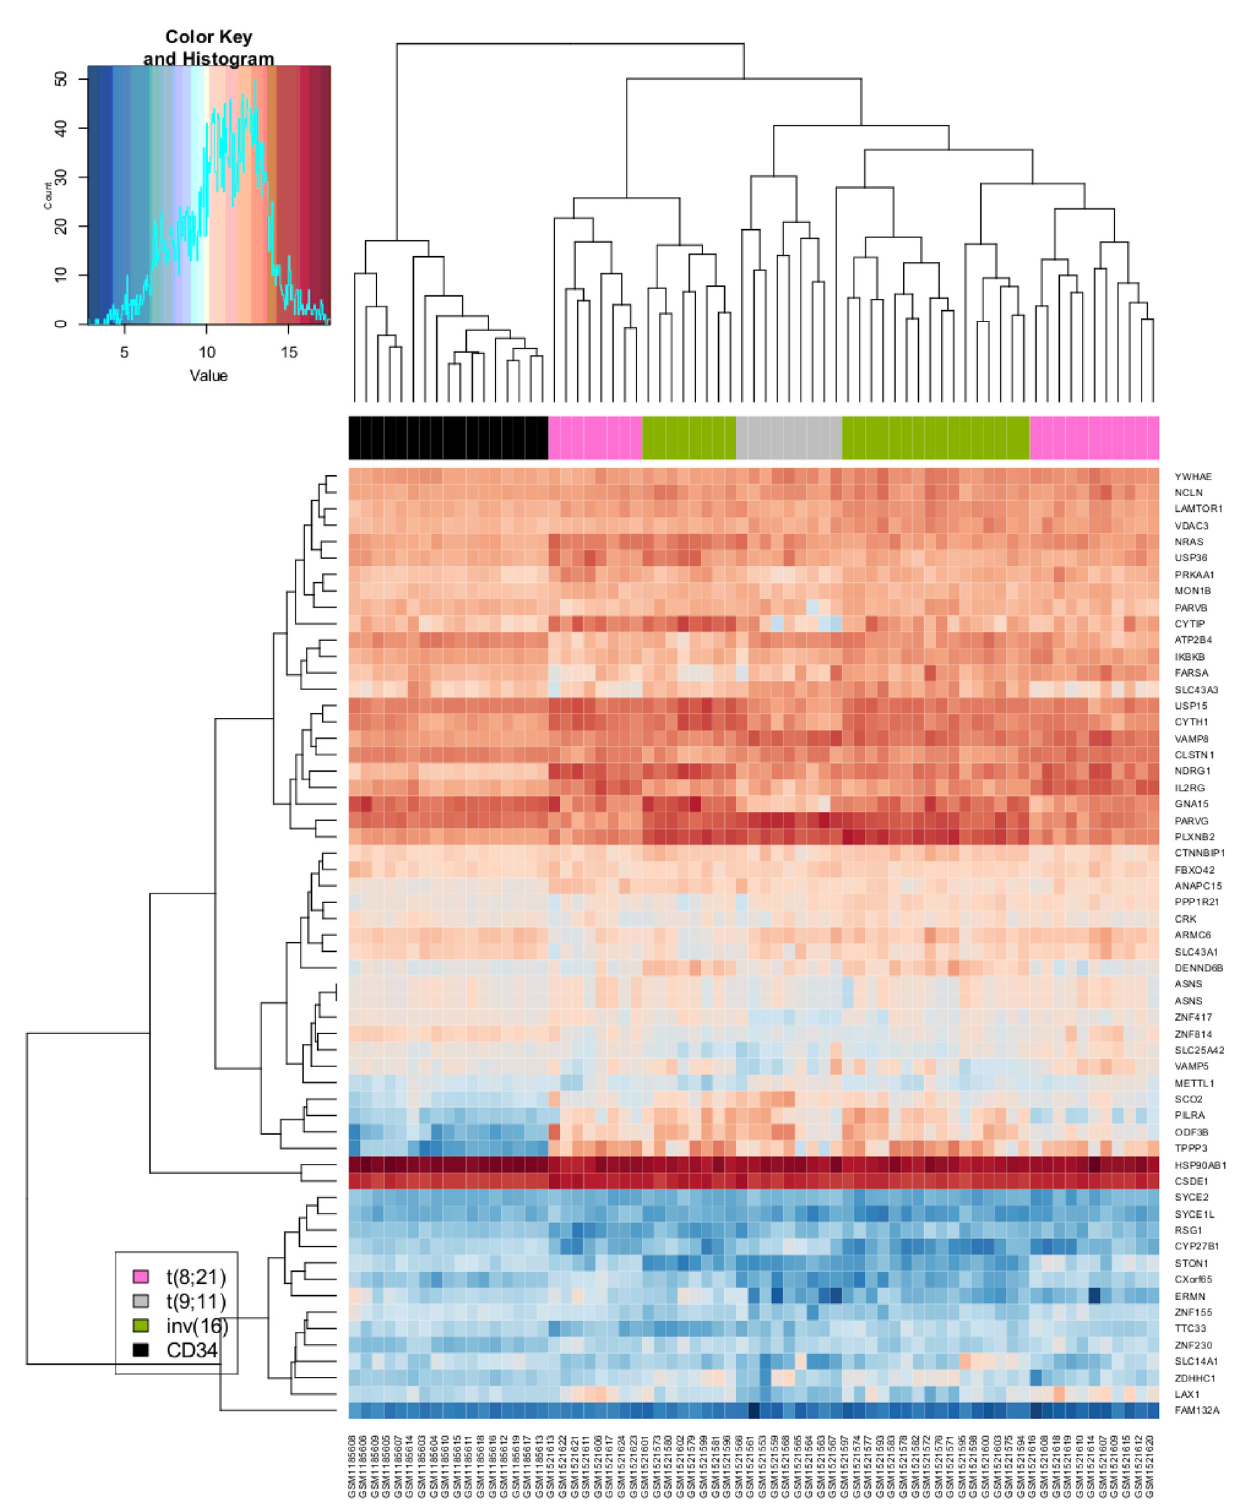
Figure 6. Expression profile of genes involved in read-through Class 2 chRNAs. The gene expression profile is analyzed by an unsupervised clustering method. Normal CD34+ HSC (CD34) and AML subgroups (LEUCEGENE RNA-seq data) were compared by analyzing the expression of a set of genes involved in read-through chRNAs. Parameters for gene selection are described in the Materials and methods section. Samples are identified by colours (black for normal CD34, pink for AML t(8;21), grey for AML t(9;11), green for AML-inv16). Gene names are indicated on the